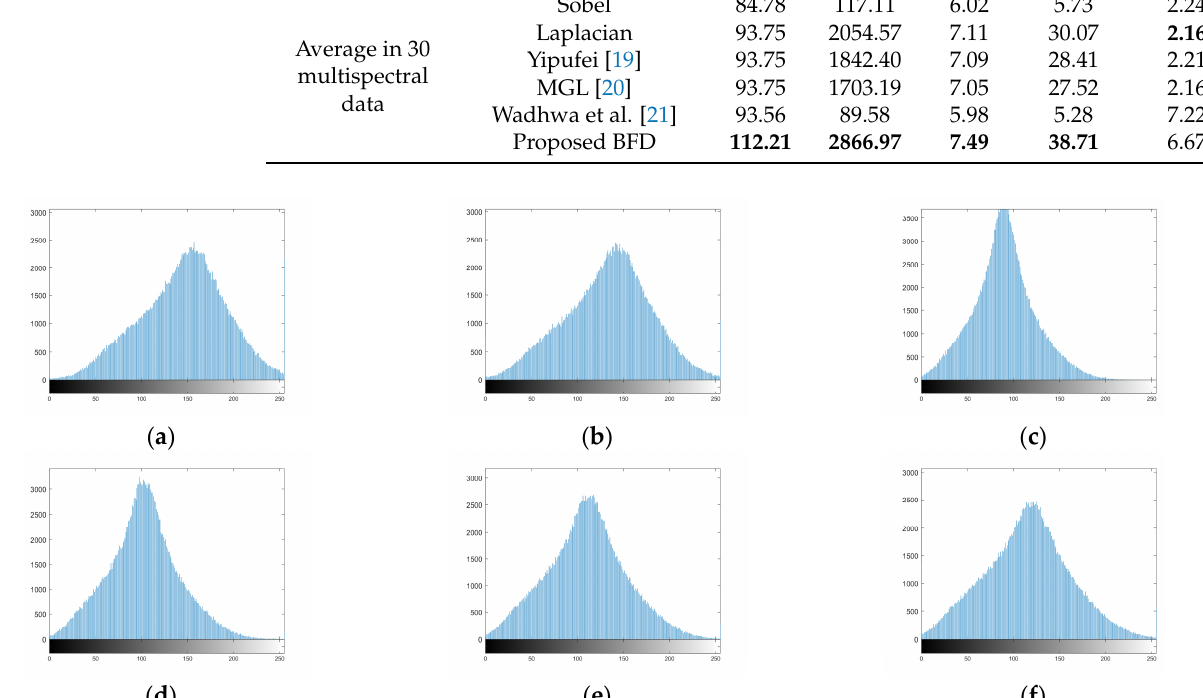
Figure 10. The histograms corresponding to enhanced data 1 by using different input bands combi- nations: ( a ) original DCP of 3-Bands; ( b ) IDCP of 3-Bands; ( c ) IDCP of 4-Bands; ( d ) IDCP of 5-Bands; ( e ) IDCP of 6-Bands; ( f ) IDCP of 7-Bands.